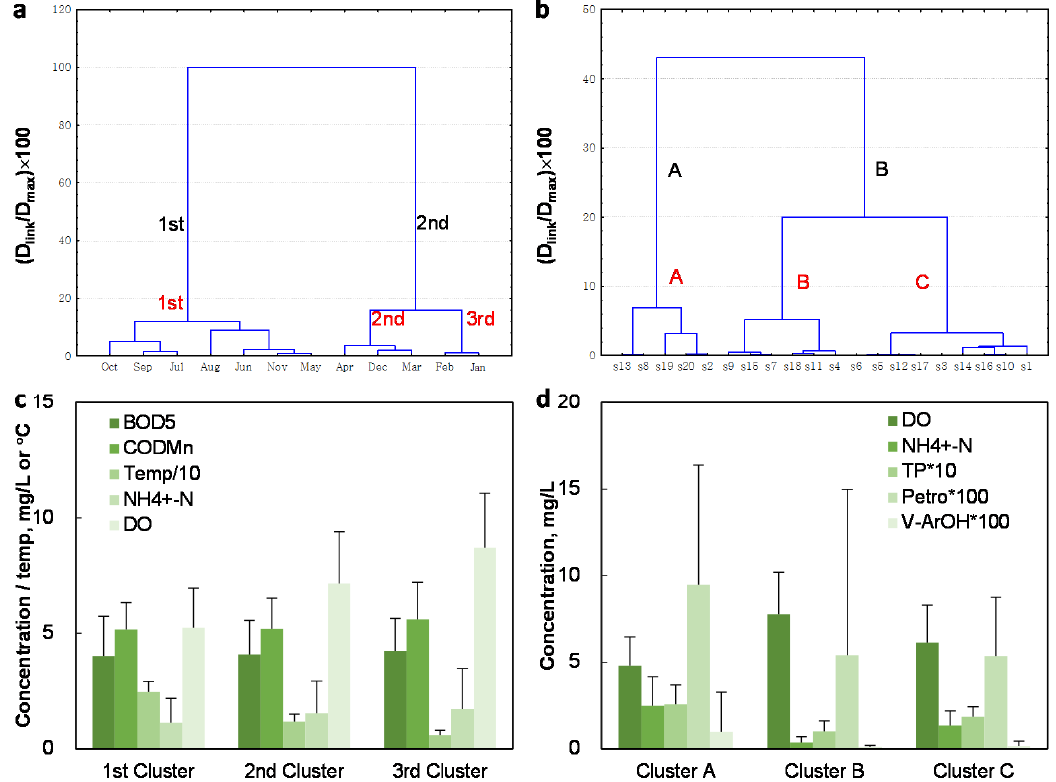
Figure 2. Temporal and spatial similarities of monitoring periods or sites produced by cluster analysis (CA). The values for water temperature, TP, Petro and V-ArOH are re-scaled by multiplying by 0.1, 10, 100 and 100. The units for concentration or temperature are mg/L and °C. ( a ) Dendrogram for temporal similarity of monitoring periods; ( b ) Dendrogram for spatial similarity of monitoring sites; ( c ) Differences in discriminant variables among two-cluster system; ( d ) Same as panel c but for three-cluster system.